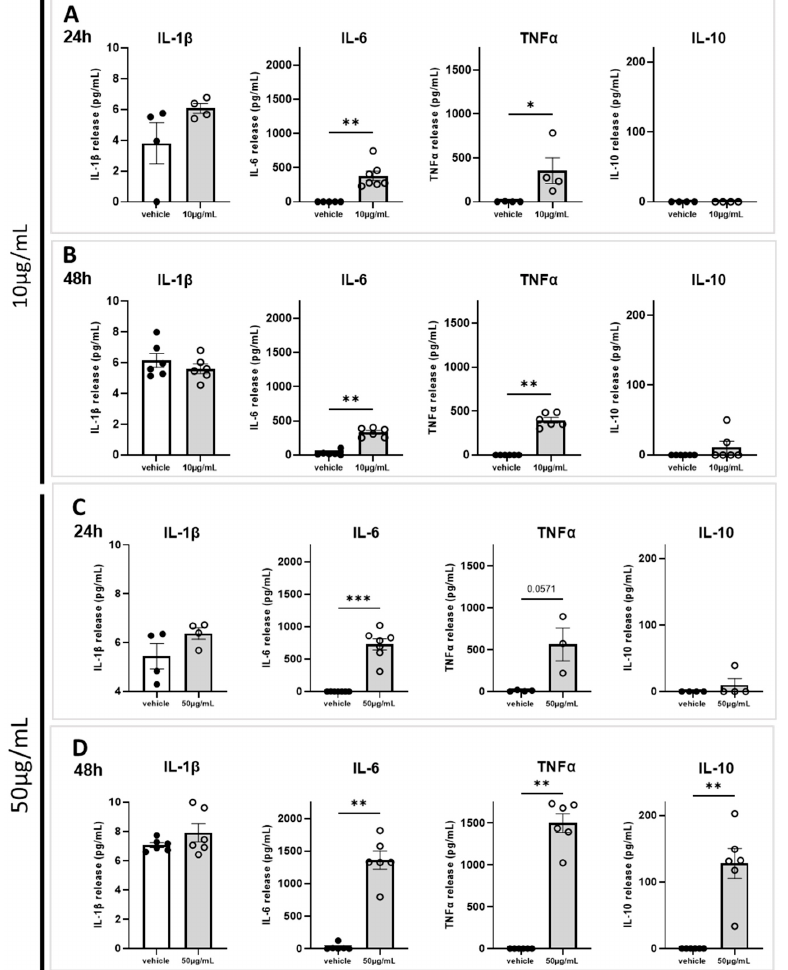
Figure 5. Effects of 10 and 50 μ g/mL of marennine on cytokine release in astrocytes and microglial cells after 24 h and 48 h of treatment. Levels of cytokines IL-1 β , IL-6, TNF α and IL-10 release in the supernatant after treatment were measured by ELISA-assay. ( A ) After 24 h of treatment with 10 μ g/mL. ( B ) After 48 h of treatment with 10 μ g/mL. ( C ) After 24 h of treatment with 50 μ g/mL. ( D ) After 48 h of treatment with 50 μ g/mL. At 10 μ g/mL, for 24 h IL-1 β : vehicle n = 4, marennine n = 4; IL-6: vehicle n = 5, marennine n = 7; TNF α : vehicle n = 4, marennine n = 4; IL-10: vehicle n = 4, ma- rennine n = 4. For 48 h IL-1 β : vehicle n = 6, marennine n = 6; IL-6: vehicle n = 6, marennine n = 6; TNF α : vehicle n = 6, marennine n = 6; IL-10: vehicle n = 6, marennine n = 6. At 50 μ g/mL, for 24 h IL-1 β : vehicle n = 4, marennine n = 4; IL-6: vehicle n = 7, marennine n = 7; TNF α : vehicle n = 4, ma- rennine n = 3; IL-10: vehicle n = 4, marennine n = 4. For 48 h IL-1 β : vehicle n = 6, marennine n = 6; IL-6: vehicle n = 6, marennine n = 6; TNF α : vehicle n = 6, marennine n = 6; IL-10: vehicle n = 6, ma- rennine n = 6. Values represent mean ± SEM. Significant differences from control are indicated: * p < 0.05; ** p < 0.01; *** p < 0.001 using Mann–Whitney test.